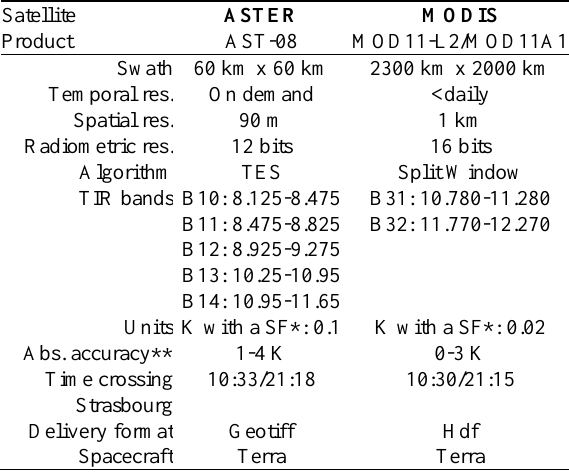
Table 1. Features of satellite data.*Scale Factor, **Depending the